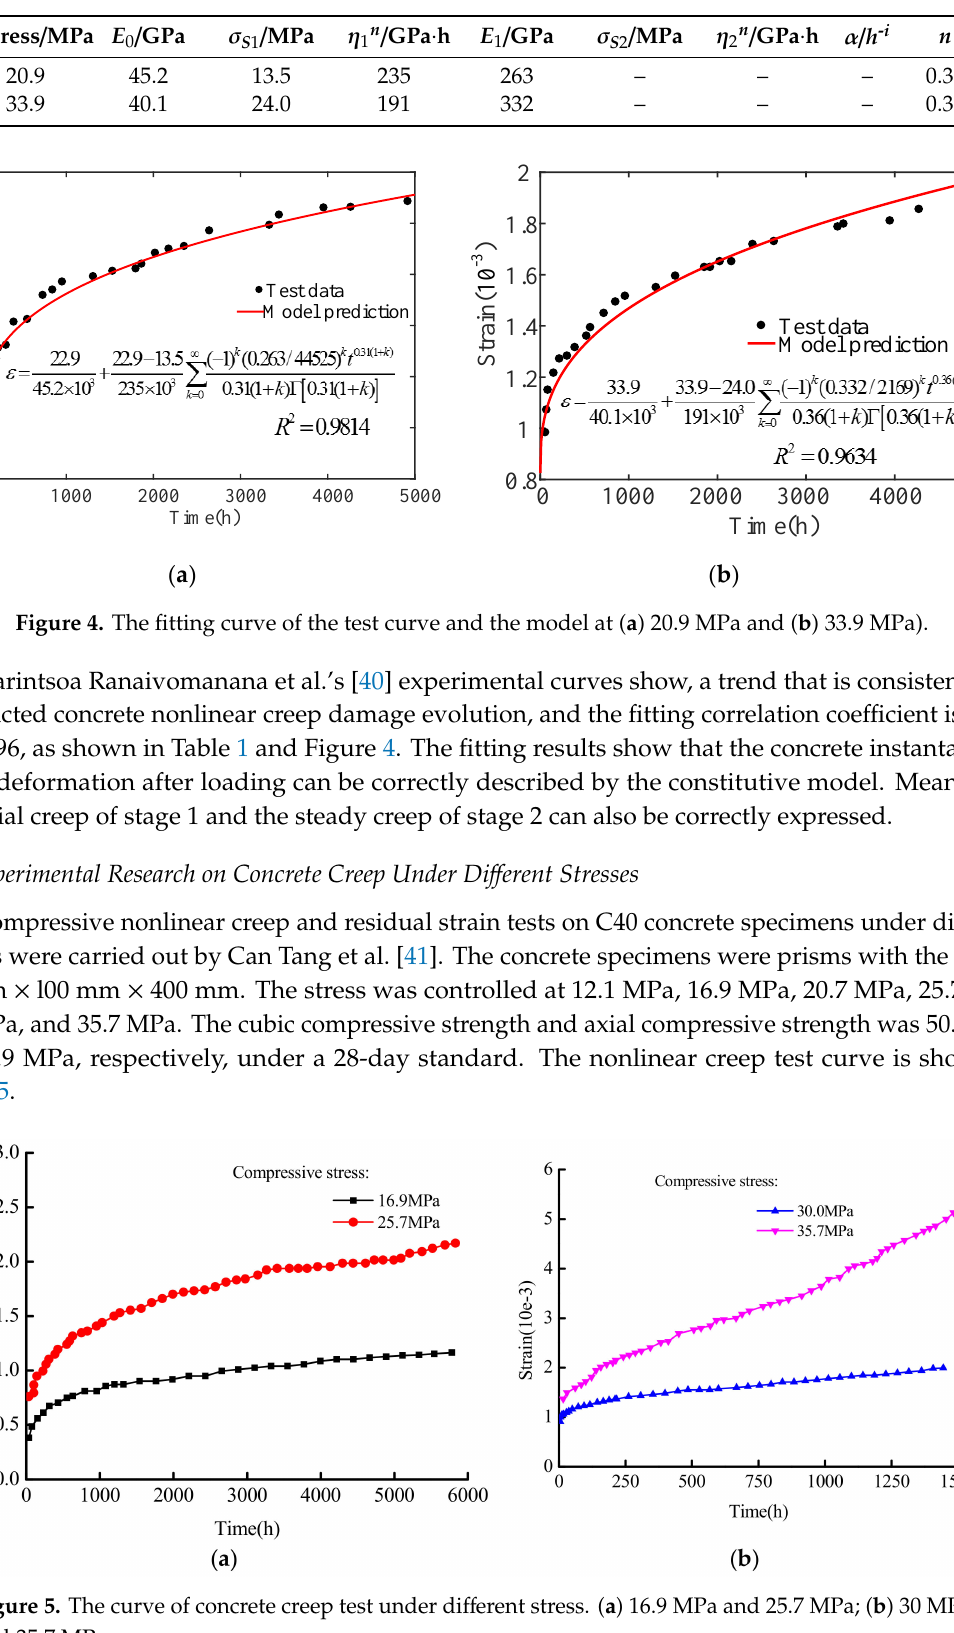
Table 1. Parameter table of concrete creep model.